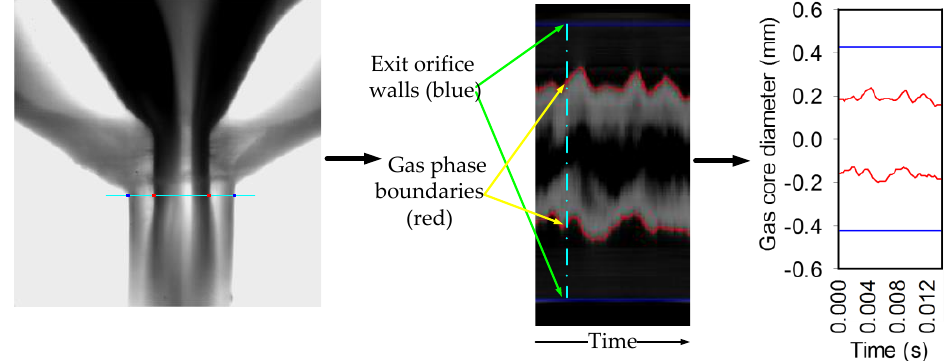
Figure 3. Processing procedure for determining the gas core diameter at the entrance of the exit orifice.